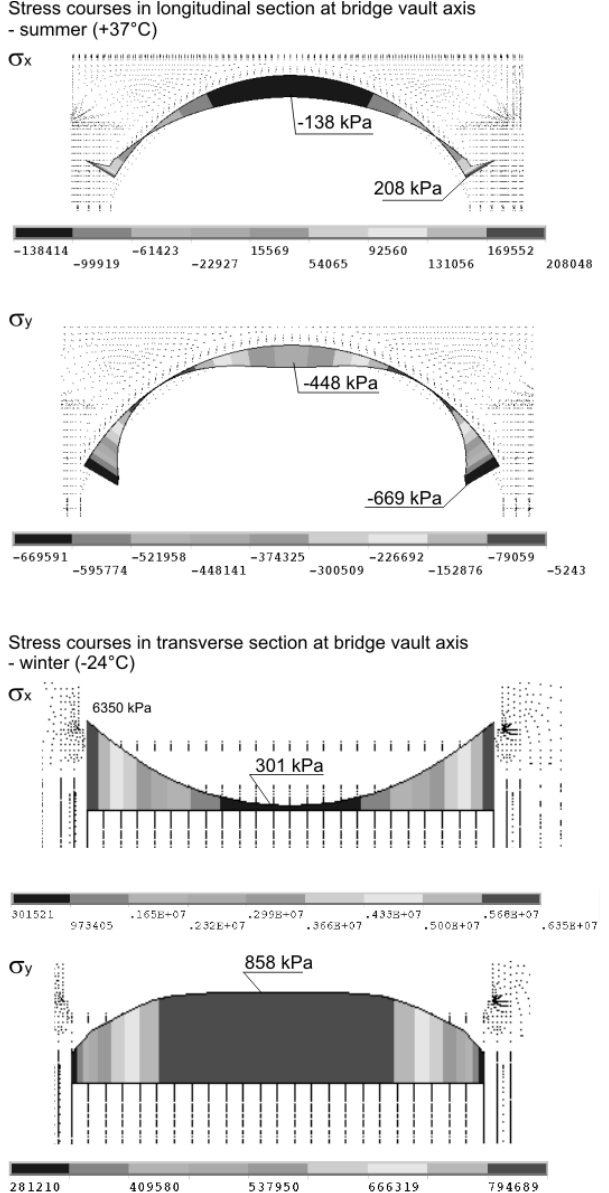
Fig 15. Time courses of normal stresses s x and s y in trans- versal (in vault crown) and longitudinal axis of the bridge vault for loading temperatures of +37 °C and –24